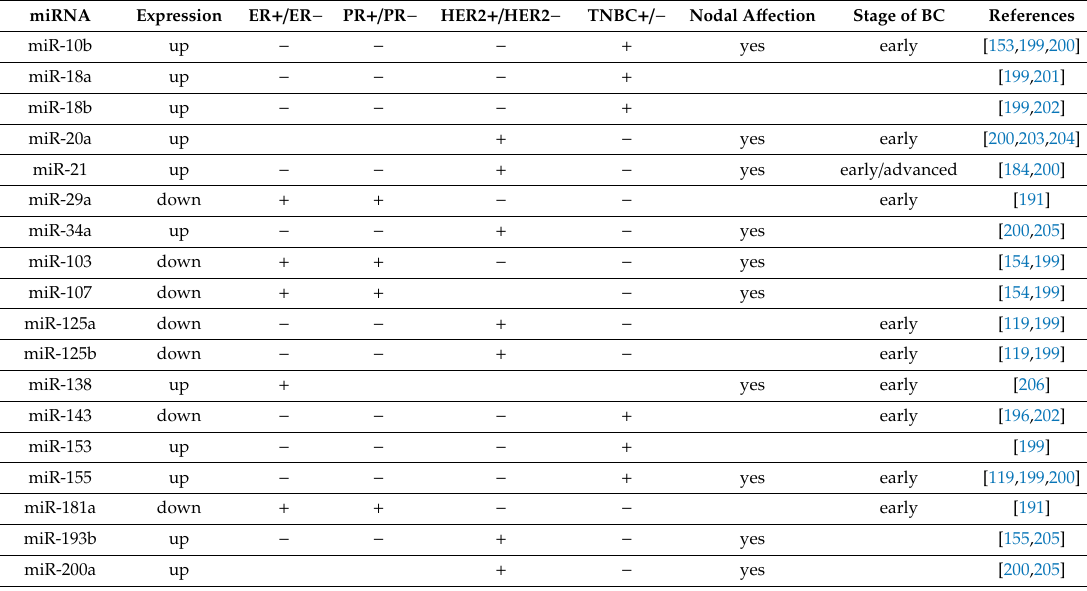
Table 3. Circulating serum miRNAs predicting BC